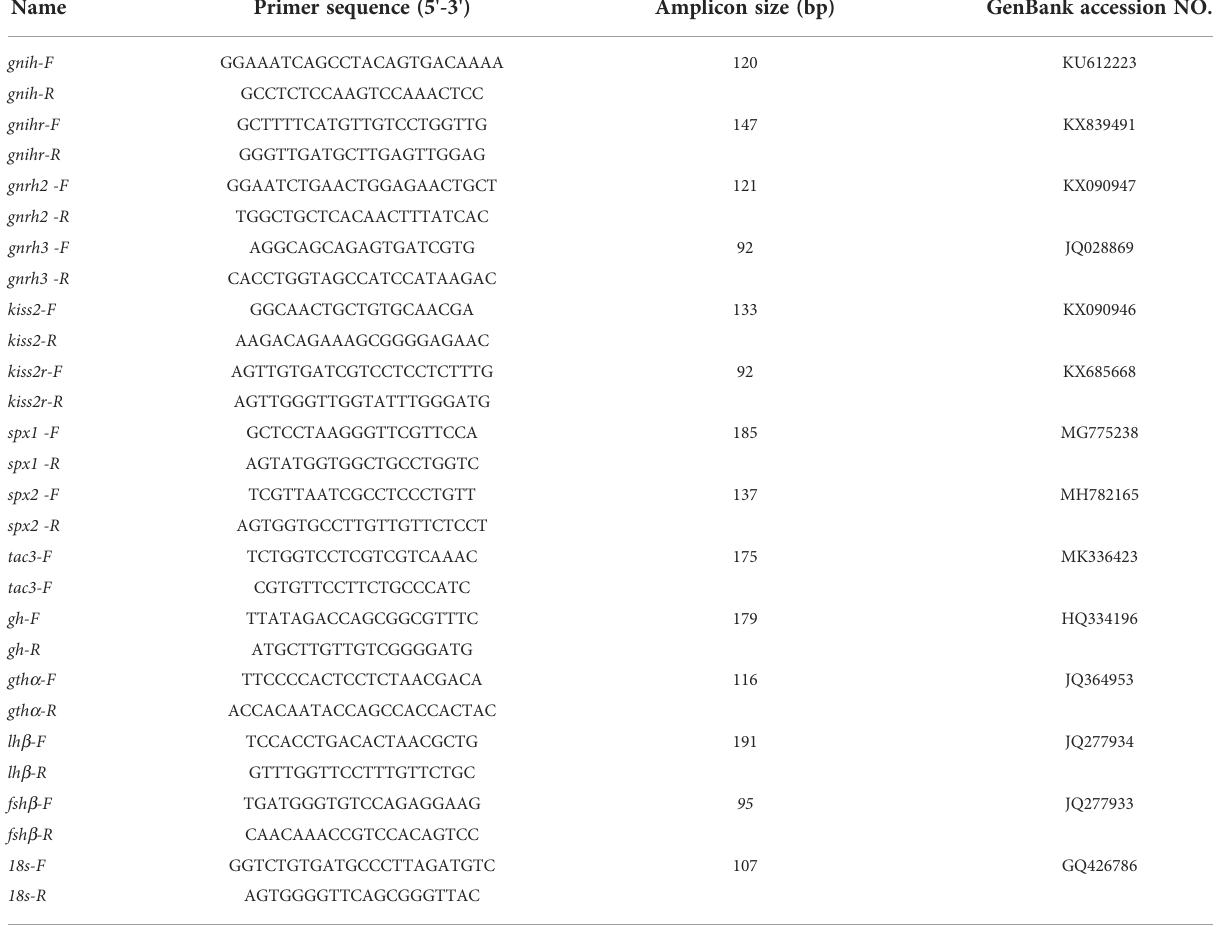
TABLE 1 List of primers for real-time quantitative